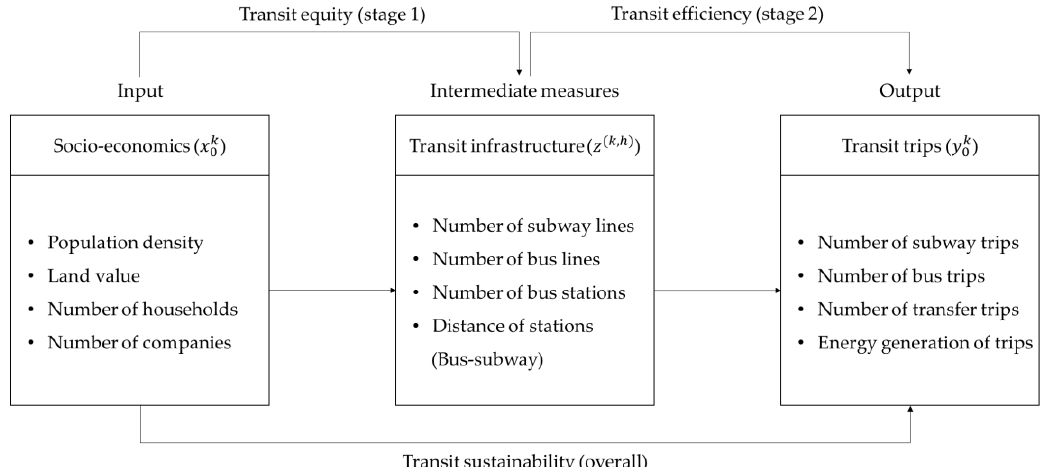
Figure 1. Network framework for measuring transit efficiency.